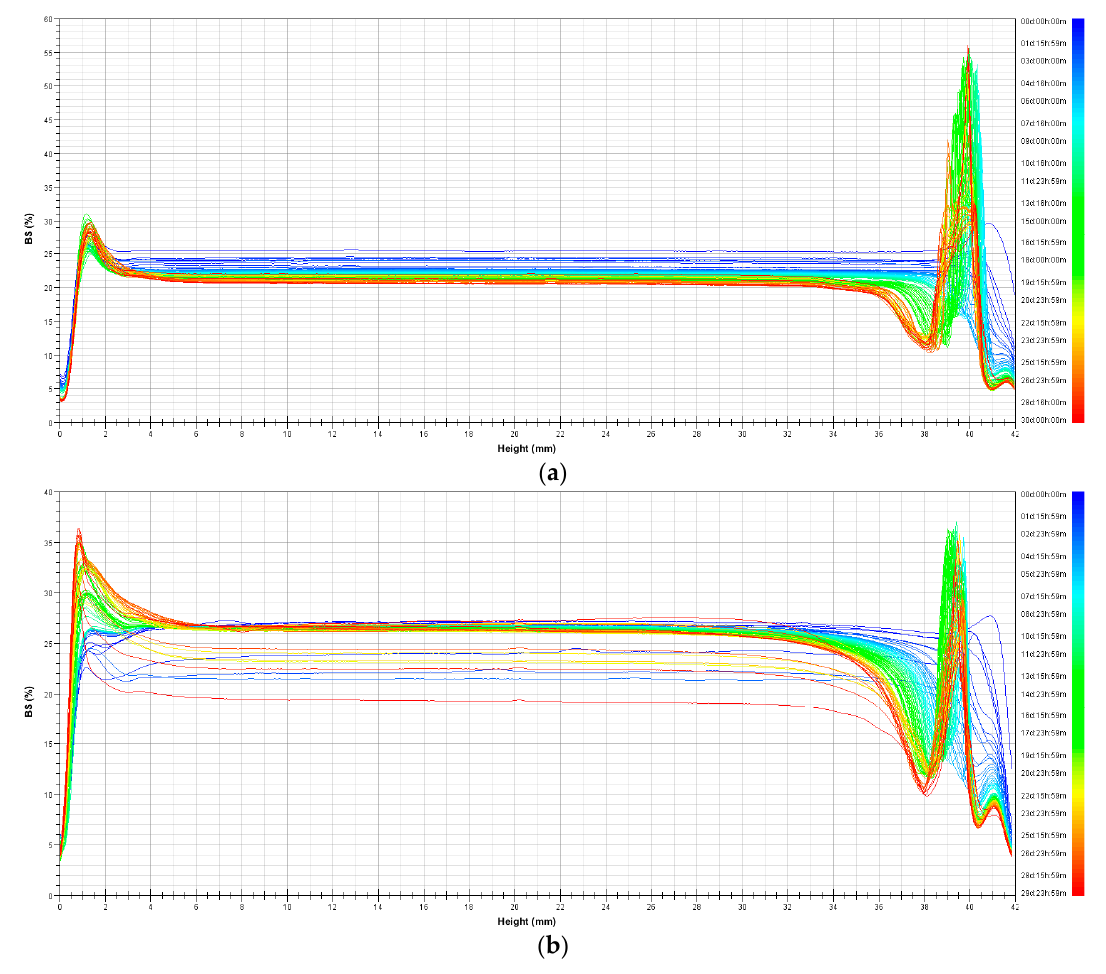
Figure 4. BS profiles of optimally formulated W/O nanoemulsions through 30 days of storage at 25 ° C: ( a ) rotor-stator mixer; ( b ) ultrasonic homogenizer.